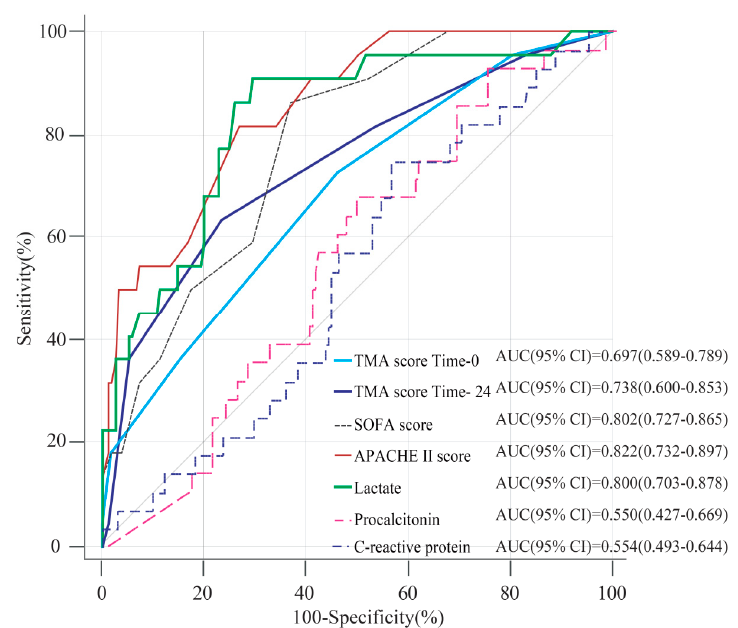
Figure 4. Comparison of the area under the curve (AUC) for the thrombotic microangiopathy (TMA) score when predicting the 30-day mortality (A). The AUC showed discriminative abilities for risk stratification of 30-day mortality. Statistical information is shown in Supplementary Table S2. The AUC of TMA at 24 h was statistically superior to the C-reactive protein and procalcitonin concentration, and it was not inferior to the Sequential Organ Failure Assessment (SOFA) score, and lactate concentration according to the early goal-directed therapy (EGDT) / SEPSIS critical pathway